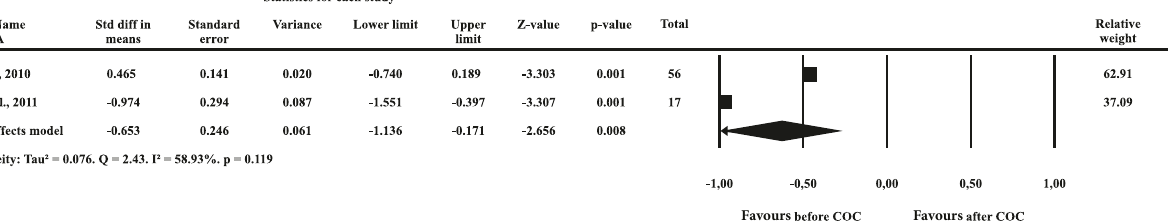
Figure 4: Forest plot of the standardized difference means of follistatin before and after the use of combined oral contraceptive in PCOS